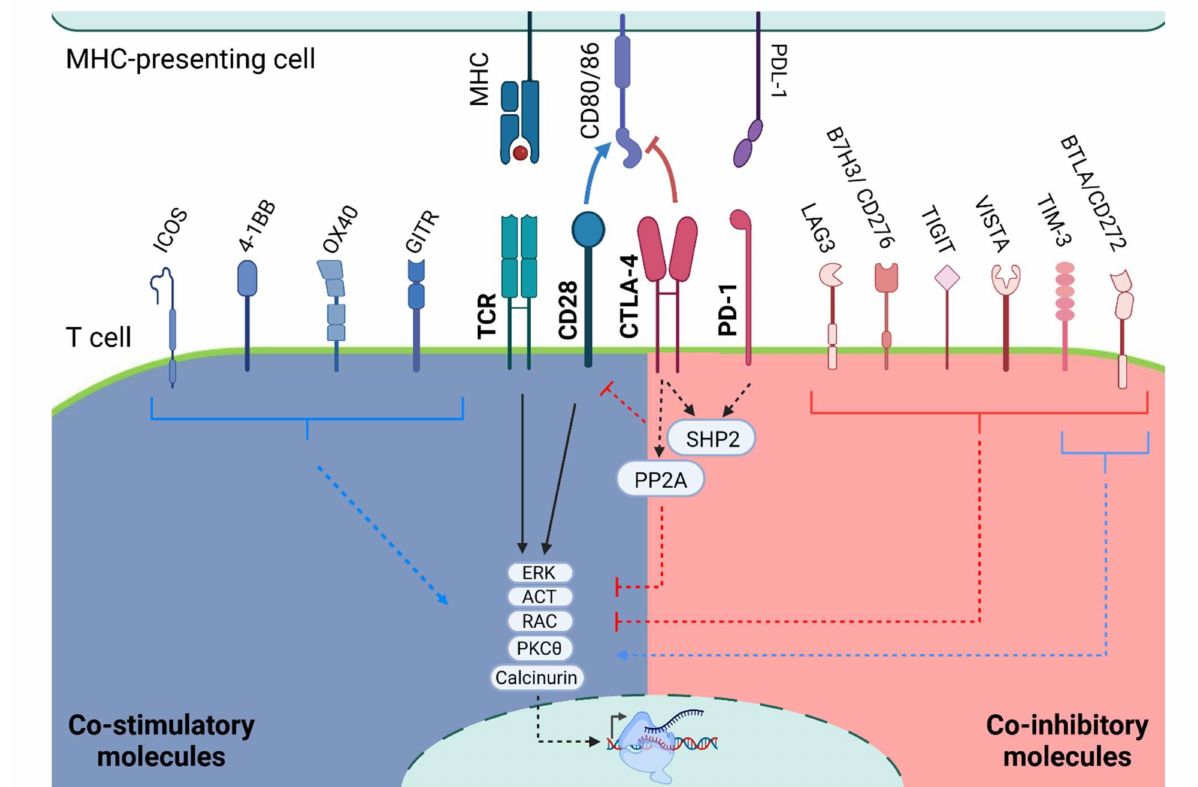
Figure 2. Co-stimulatory and Co-inhibitory signaling. Schematic representation of TCR activation with the co-stimulatory and co-inhibitory molecules. TIM-3 and BTLA have shown both inhibitory and stimulatory activity. It is worth noting that the T-cell signaling depicts a general interaction of T cells with any MHC-presenting cells and is not specific to one cell type: MHC, major